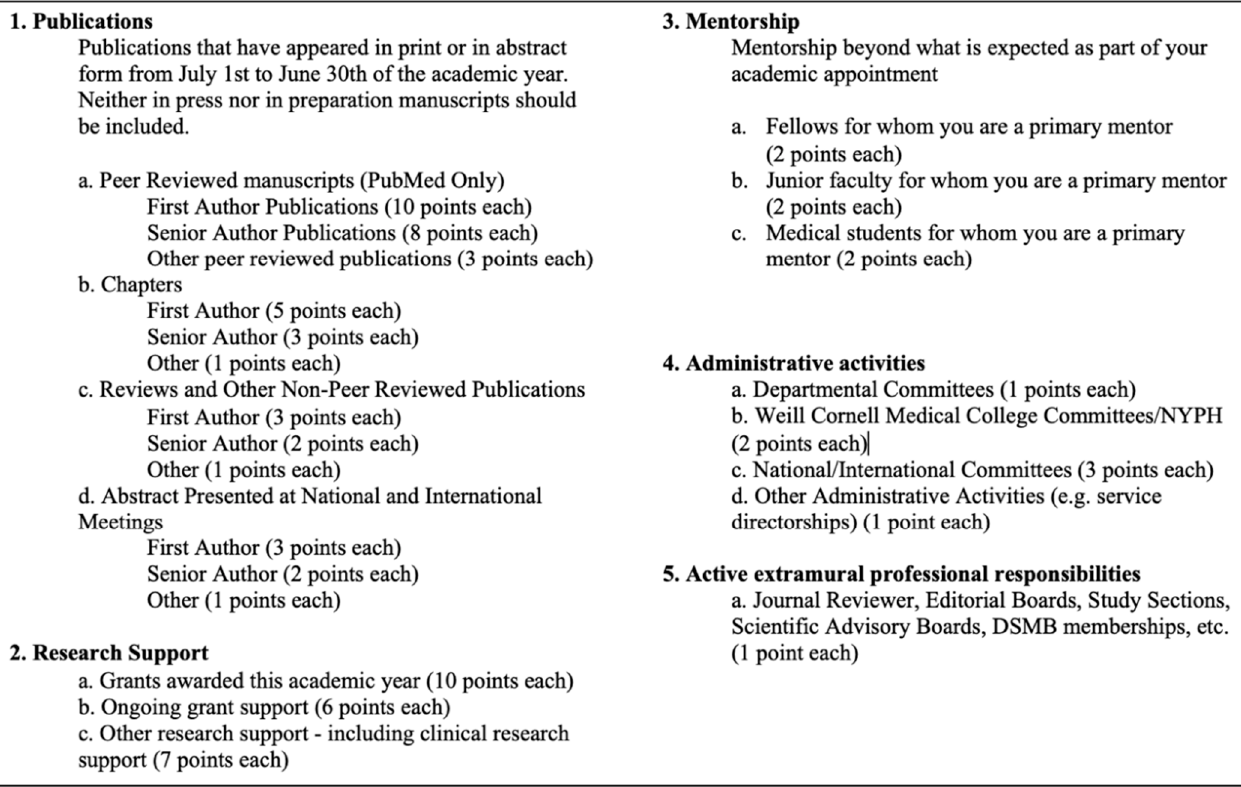
Table 1. Mann–Whitney U pairwise testing of median publications before and after implementa- tion of points system .